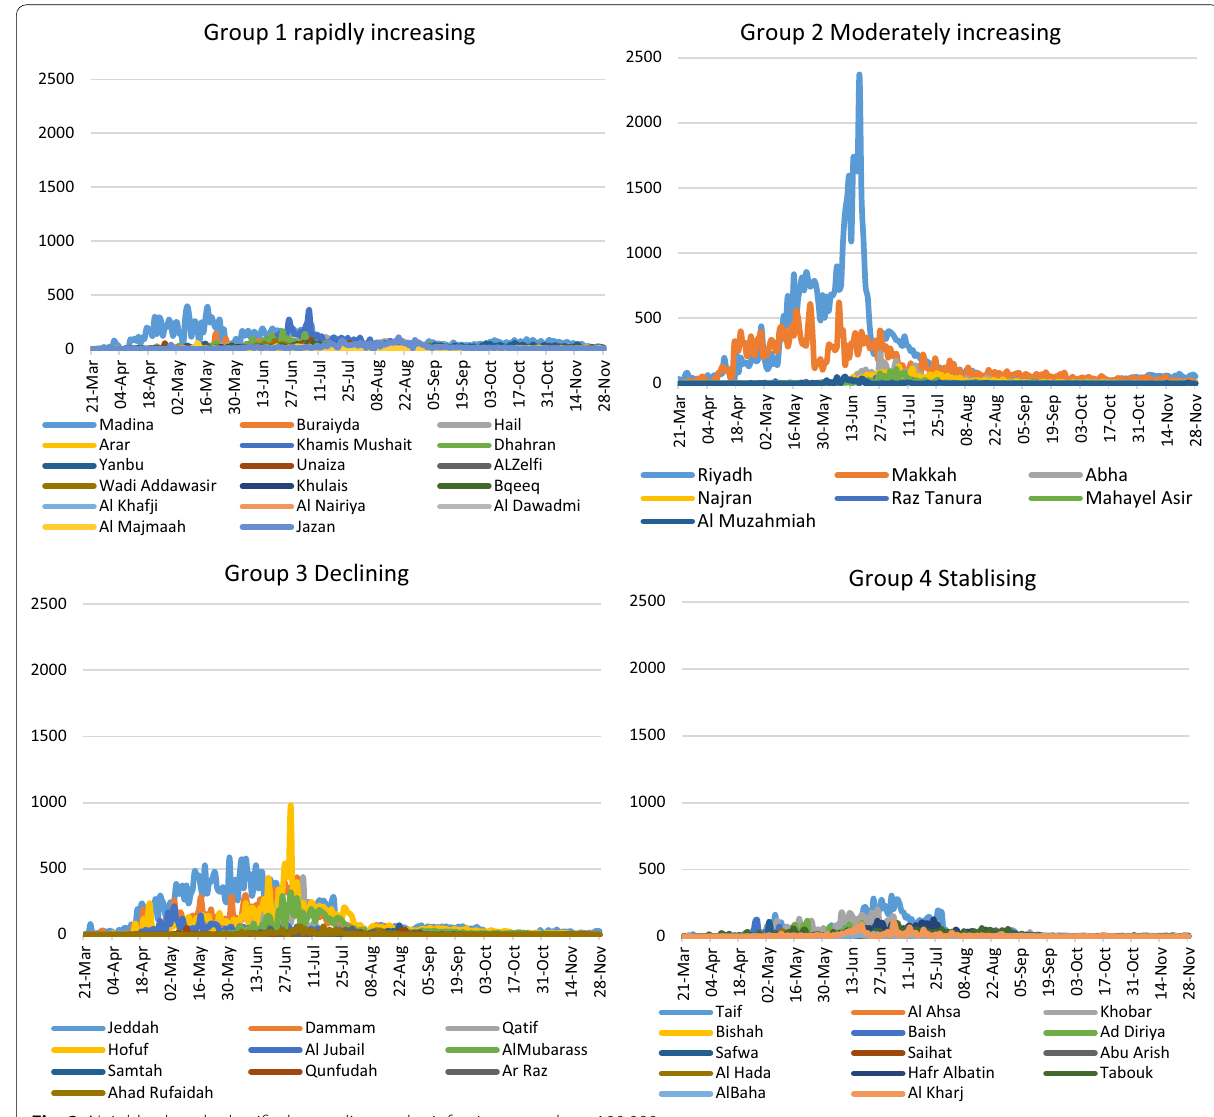
Fig. 2 Neighborhoods classified according to the infection spread per 100,000